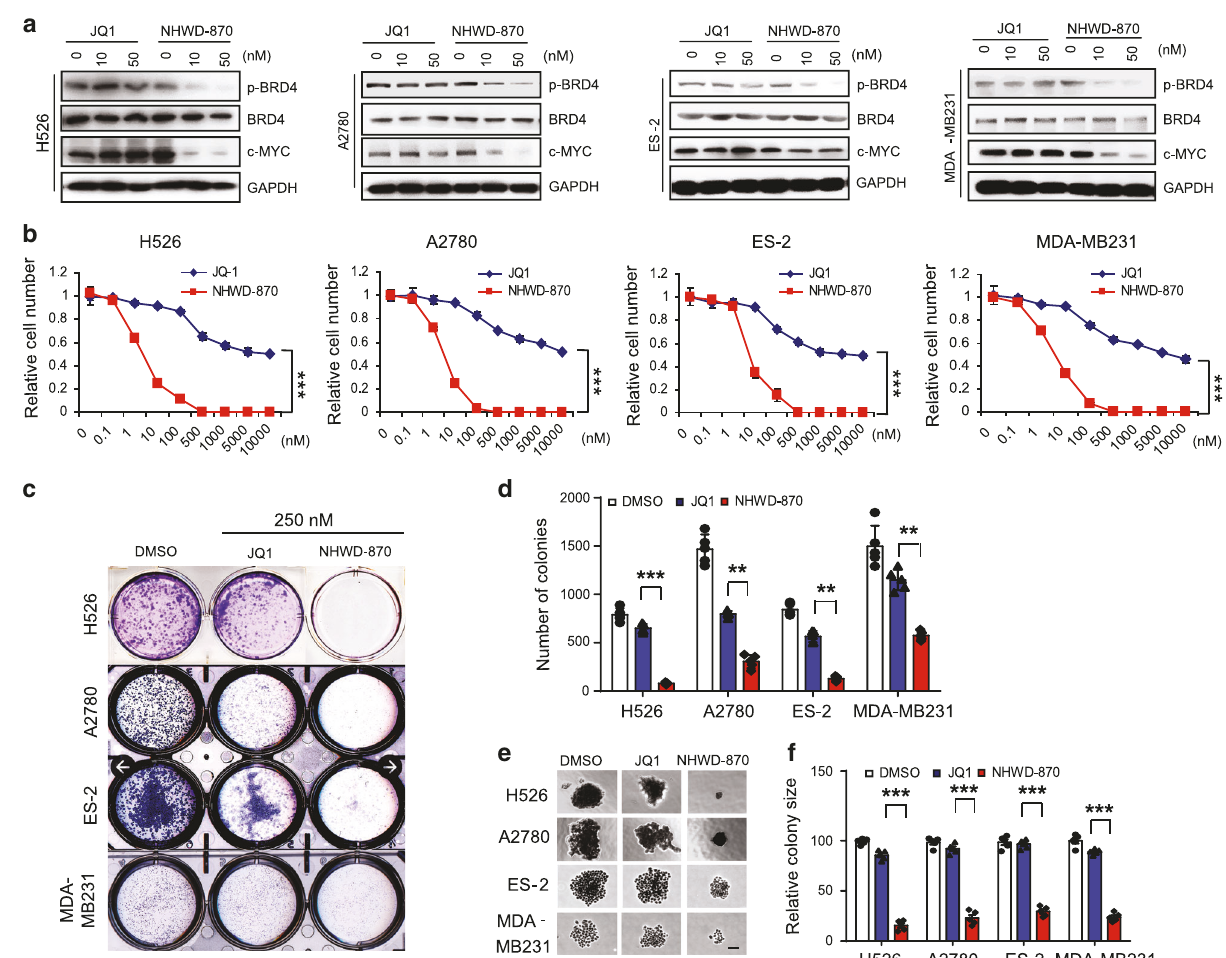
Fig. 2 NHWD-870 inhibited BRD4 phosphorylation and c-MYC expression, and suppressed cell growth. a Representative western blot analysis of p- BRD4 (s484/488), BRD4, c-MYC, and GAPDH after treatment of MDA-MB231, SUM159, A2780 ES-2, and H526 cells with JQ-1 or NHWD-870 at the indicated concentrations for 24 h. GAPDH served as the loading control. Selected from three independent experiments. b MTT assays of H526, A2780, ES- 2, and MDA-MB231 cells treated with JQ-1 or NHWD-870 at the indicated concentrations for 5 days. Data are presented as mean ± SEM from three independent experiments. c , d Clonogenic assays of H526, A2780, ES-2 and MDA-MB231 cells treated with 250nM JQ-1 or NHWD-870 for 5 days. Shown are representative images ( c ) and quanti fi cation of colonies ( d ). Data are presented as mean ± SEM from fi ve independent experiments. e , f 3D matrigel assays of H526, A2780, ES-2, and MDA-MB231 cells treated with 100 nM JQ1 or NHWD-870. Shown are representative images ( e ) and quanti fi cation of relative colony sizes ( f ). Scale bar, 50 μ m. Data are presented as mean ± SEM from fi ve independent experiments. p values were